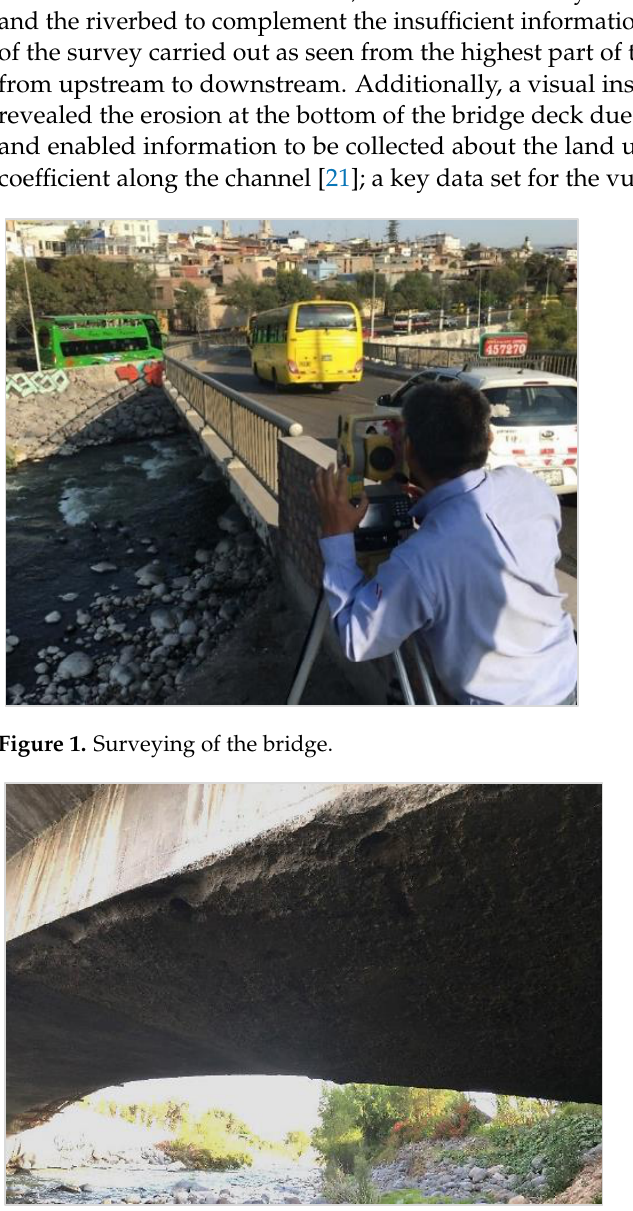
Figure 2. Erosion on the deck of the